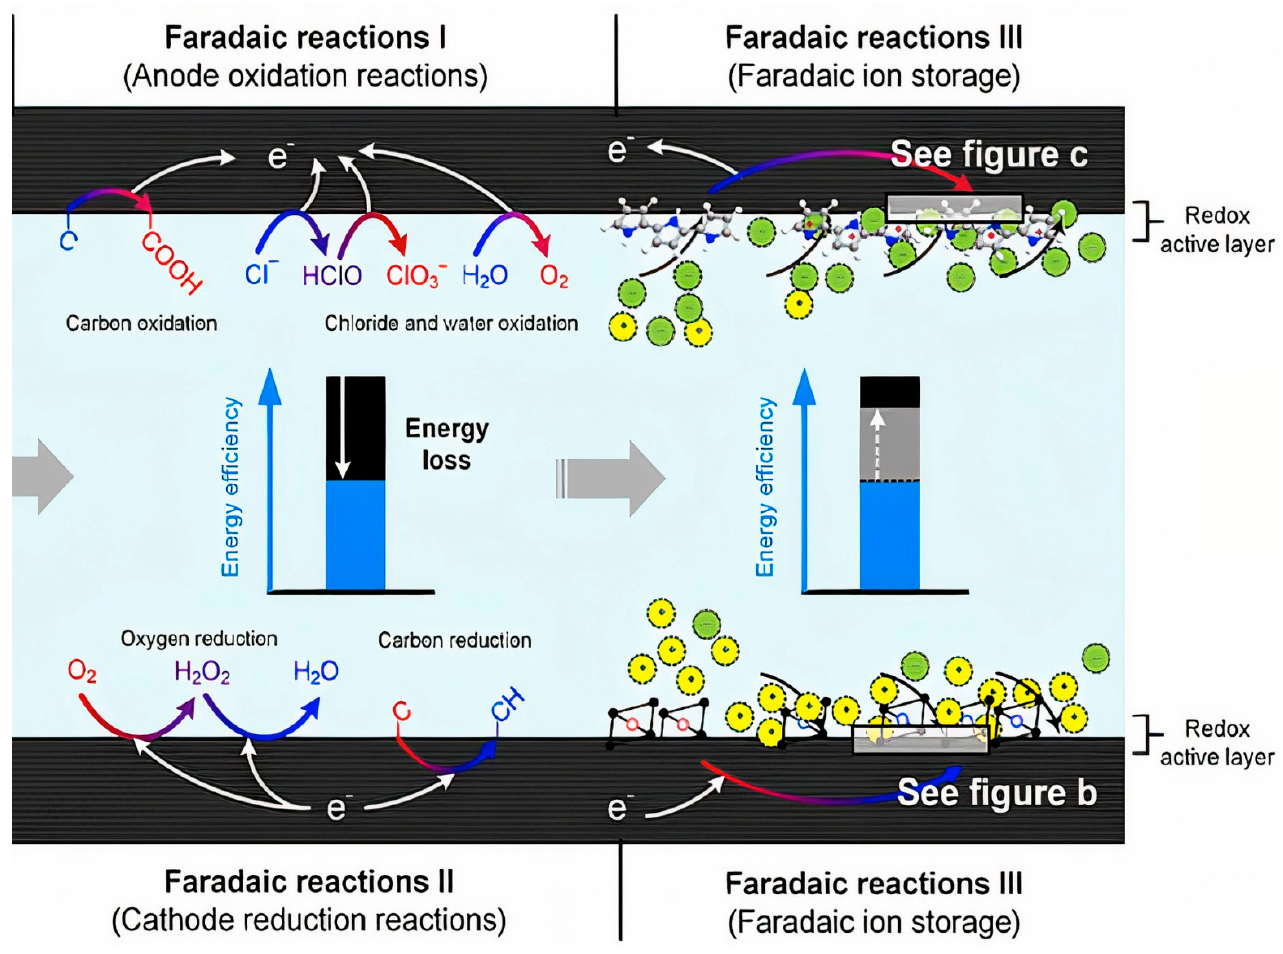
Figure 11. Schematic of three types of Faraday reactions in the capacitive deionization process. (Faradaic reaction I) Anode oxidation reaction, (Faradaic reaction II) Cathode reduction reaction, and (Faradaic reaction III) Faradaic ion storage. Reprinted/adapted with permission from Ref. [98]. 2018, Zhang, C.; He, D.; Ma, J.; Tang, W.; Waite, T.D.